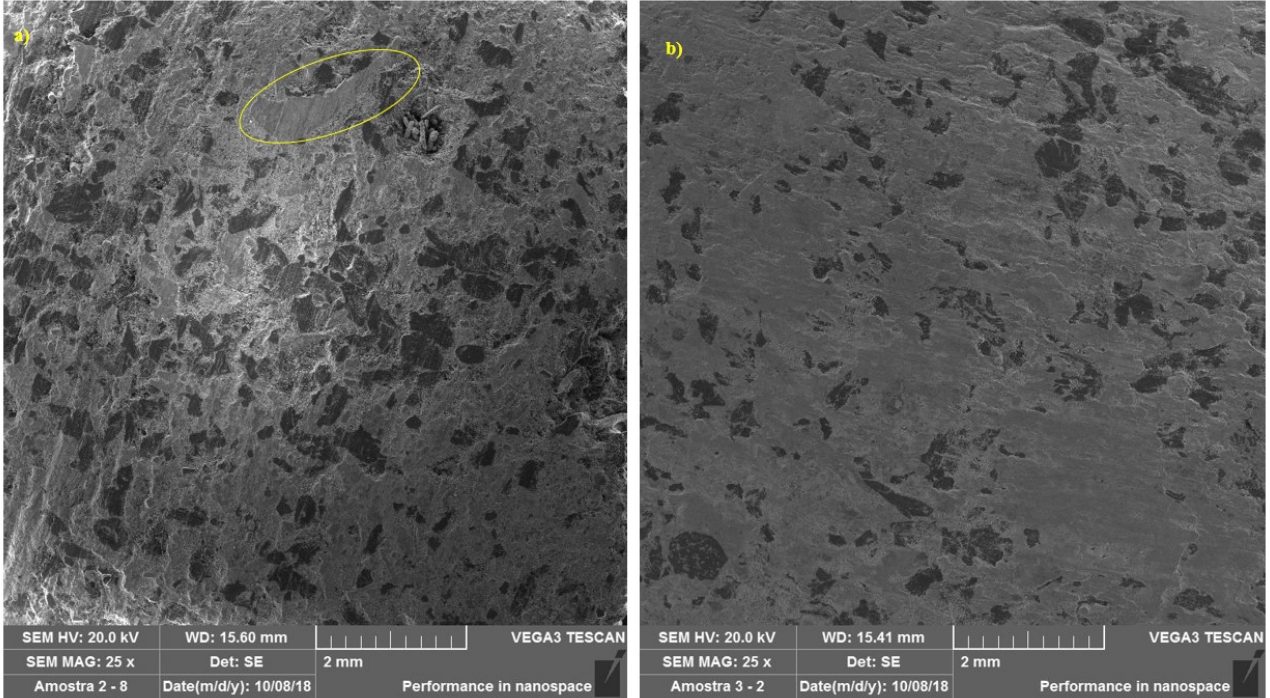
Figure 7. SEM images—25 × : ( a ) simulated downhill; ( b ) emergency braking. Note larger plateaus and a larger relative area of the sample containing plateaus in ( b ).